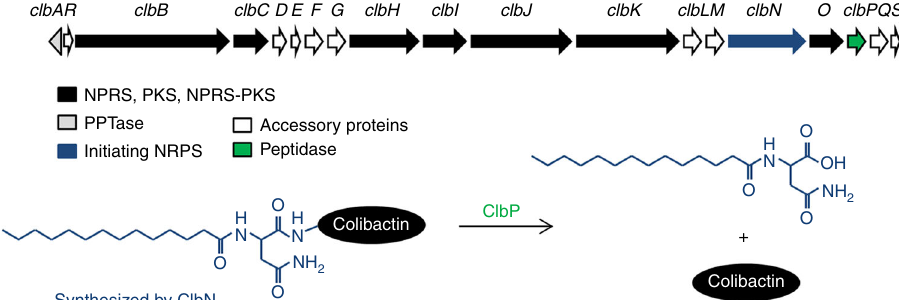
Fig. 1 Schematic representation of the pks genomic island. This cluster of genes encodes the enzymes and accessory proteins (arrows) necessary for synthesis of precolibactin in E. coli . Precolibactin is cleaved by a peptidase encoded by clbP (green arrow) into active colibactin and a cleavage product, mainly C14Asn OH , synthesized by the initiating NPRS encoded by clbN (blue